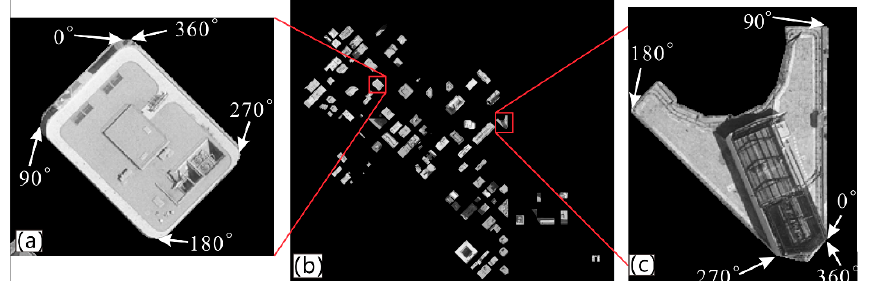
Figure 12. Generation results of DBM-based T 2 OM on dataset 1. ( b ) DBM-based T 2 OM; ( a , c ) are enlarged windows of the two regions.